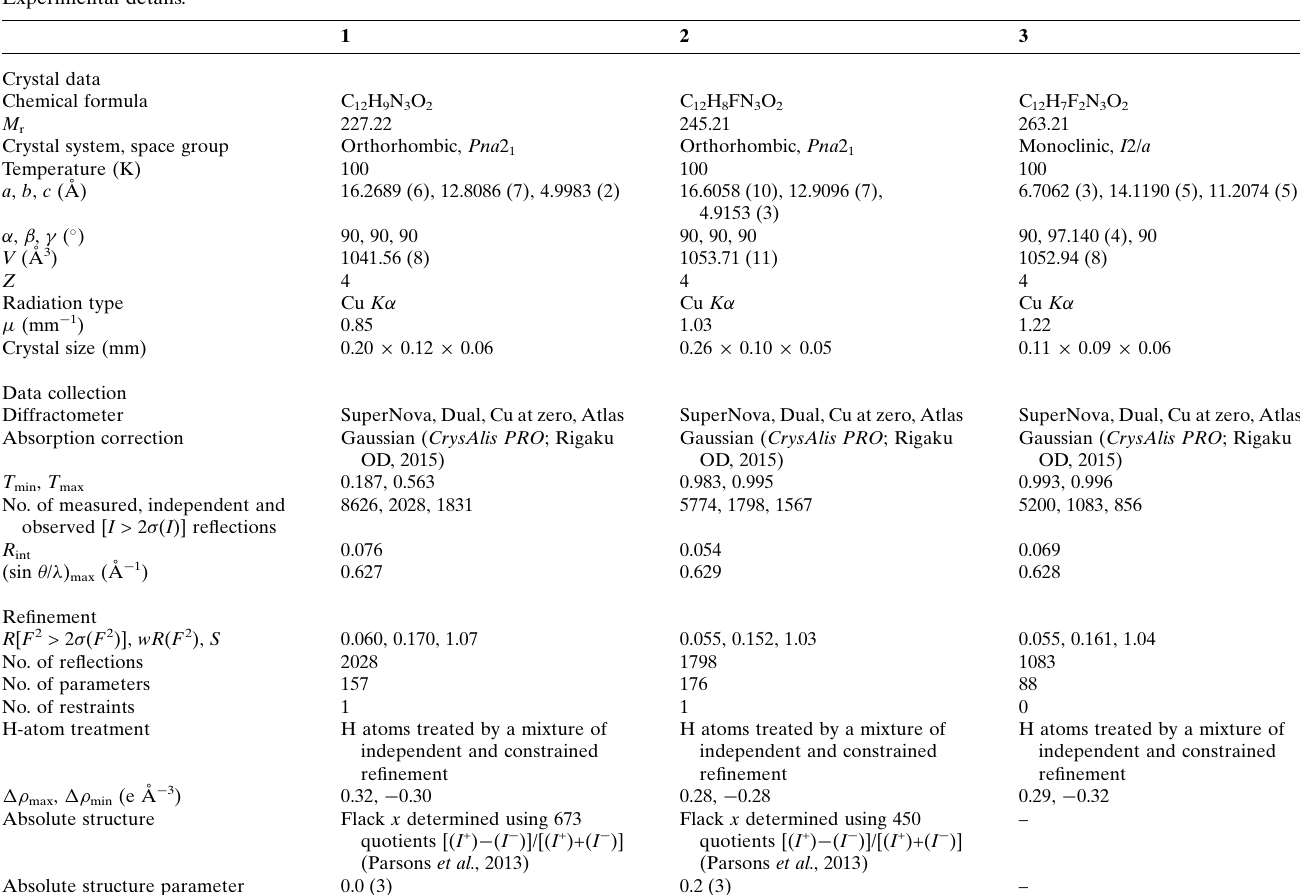
Table 4 Experimental